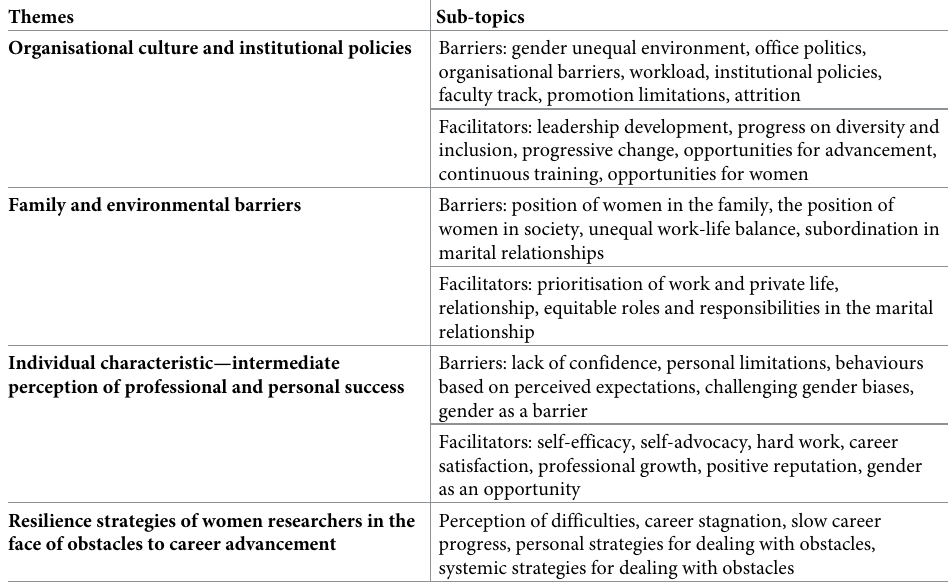
Table 3. Summary of the thematic analysis of the main theme definitions and sub-theme